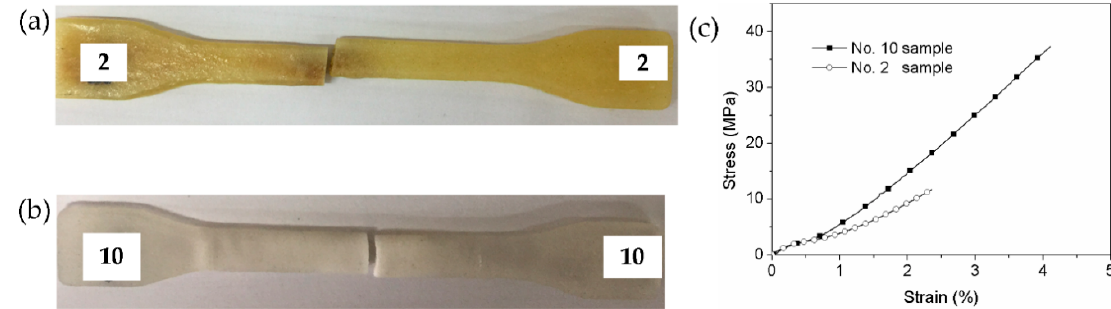
Figure 12. Microstructure of fracture surface. ( a ) Curing agent T31; ( b ) curing agent 593.